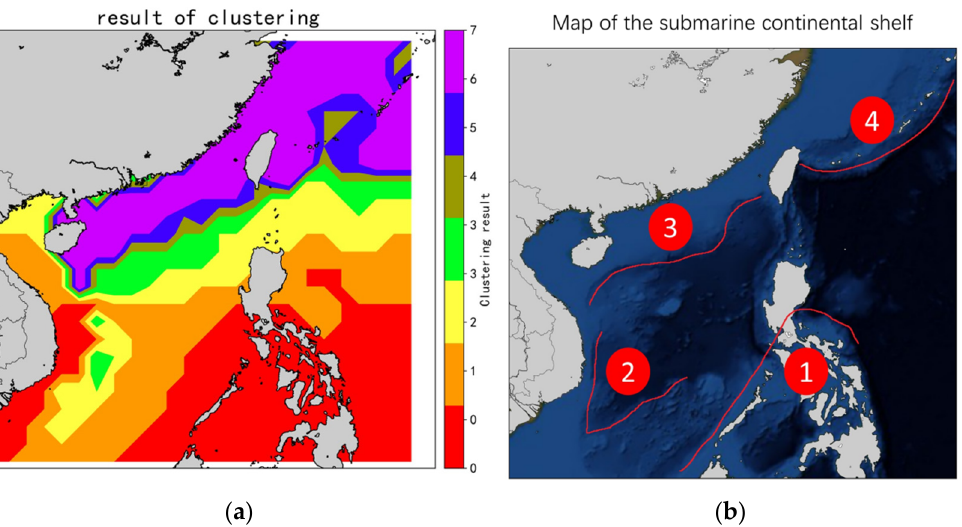
Figure 8. Cluster result map of CENS and visualization of the submarine continental shelf. ( a ) is the clustering result of CENS. The color bar on the right side of ( a ) is the result of clustering. For example, red is the area of cluster 1, and orange is the area of cluster 2. ( b ) is the submarine continental shelf in the South China Sea. The depth of the color in the ( b ) indicates the water depth.